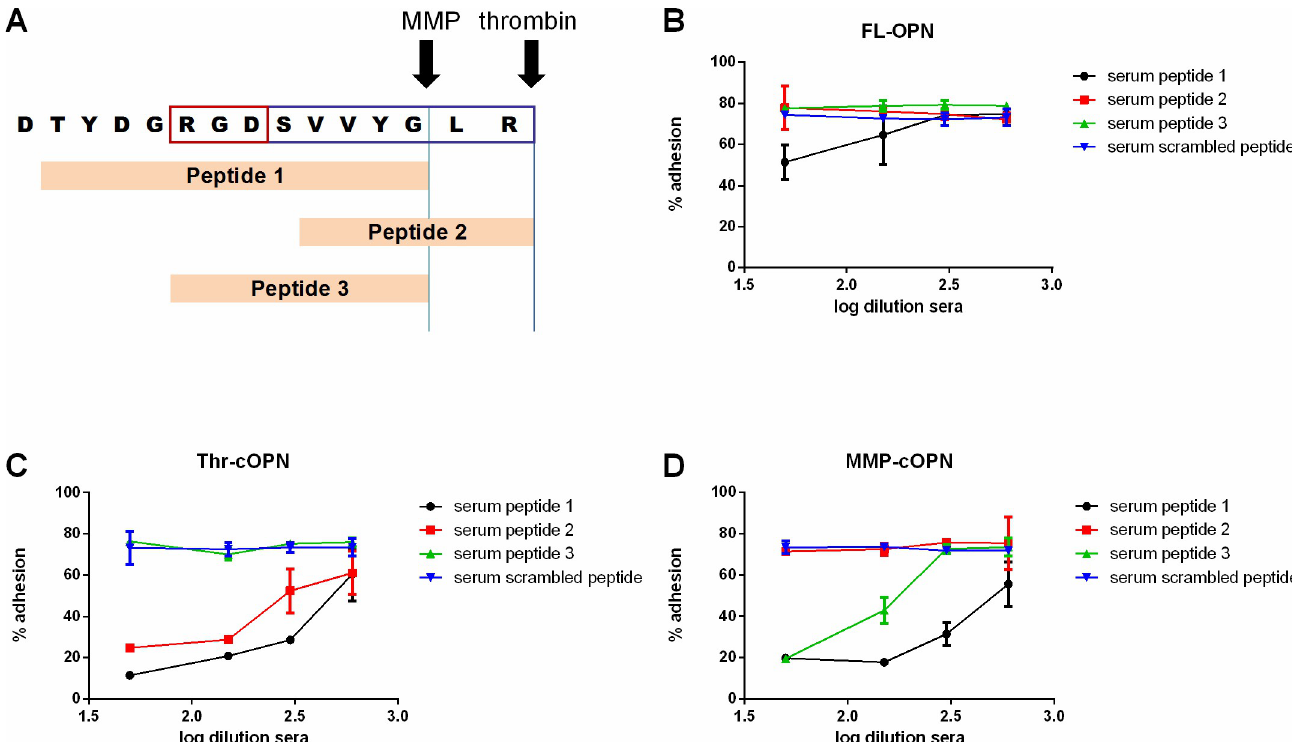
Fig 7. The OPN-T cell interaction can be antagonized by serum from active vaccination with OPN peptides. (A) 3 peptides derived from the OPN sequence plus a scrambled peptide were injected into mice. The MMP and thrombin cleavage sites are delineated by the vertical lines. The RGD binding site for α v β 3 integrins is marked with a red box and the SVVYGLR binding site for α 4 β 1 and α 4 β 9 integrins is marked with a mauve box. (B) Interference of postimmune serum with binding of Jurkat T cells to FL-OPN. (C) Interference of postimmune serum with binding of Jurkat T cells to Thr-cOPN. (D) Interference of postimmune serum with Jurkat T cells binding to MMP-cOPN; The different sera for the experiments were pooled from 5 mice with the OPN-T cell interaction determined once with each point detected in duplicate; mean ± SD depicted.